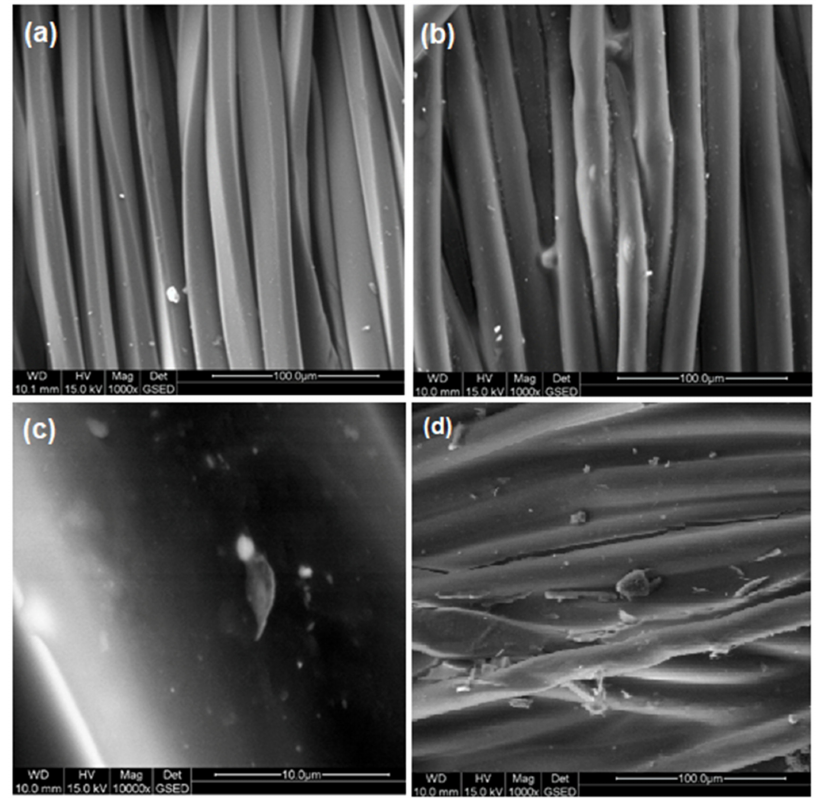
Figure 4. SEM micrographs of raw ( a ) and coated ( b – d ) PES textile